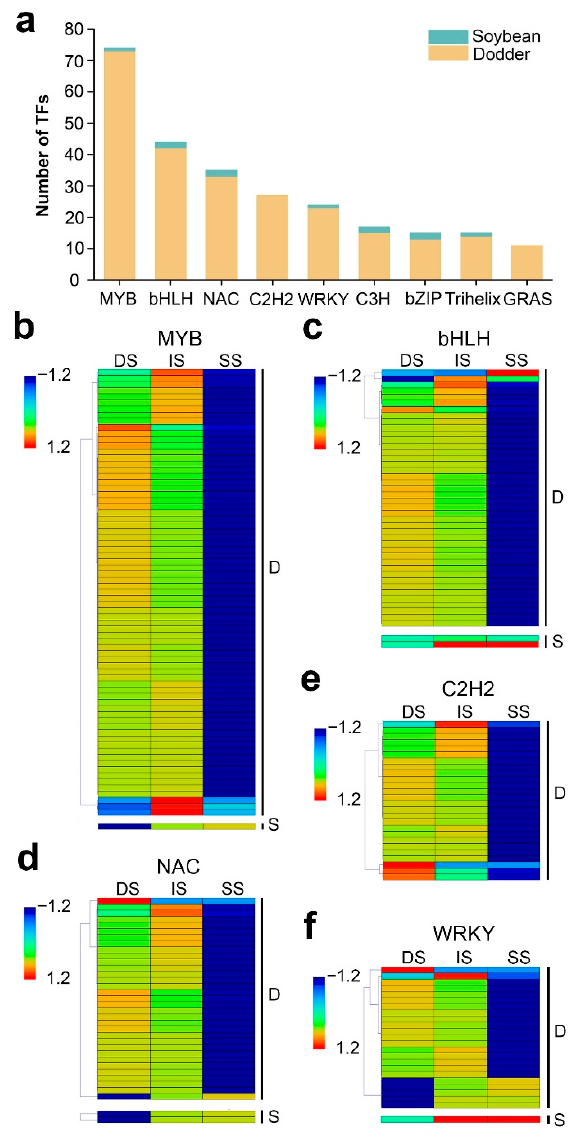
Figure 7. Distribution and expression patterns of transcription factors: ( a ) Details of the number for TFs identified from mobile lncRNAs target genes of dodder and soybean. Data are sorted by number of lncRNAs. Only categories with more than 10 mobile transcripts identified as transcription factors are shown; ( b – f ) Heatmap of the expression patterns of the first five most numbers of TFs in the tissues of dodder stems (DS), interface stems (IS), and soybean stems (SS), including MYB ( b ), bHLH ( c ), NAC ( d ), C2H2 ( e ), and WRKY ( f ). ‘D’ represents mobile dodder lncRNAs target genes. ‘S’ represents mobile soybean lncRNAs target genes. The gene expression is based on the z-scores of log 2 (FPKM) value. The blue and red colors indicate low and high expression levels,